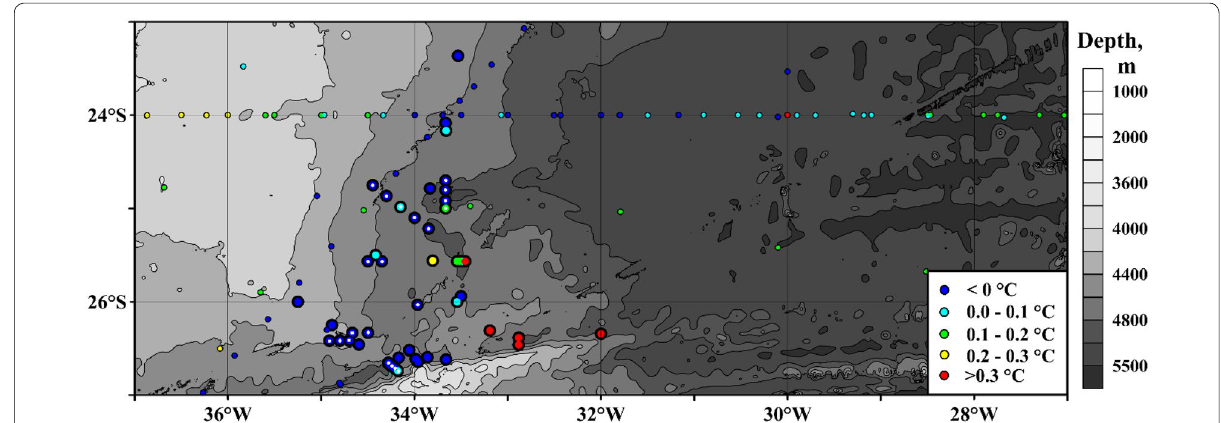
Fig. 2 Bathymetry of the study region north of the Vema Channel based on (GEBCO 2019). Locations of our CTD/LADCP casts in 2003–2020 (large circles) and historical stations (small circles) are shown. The corresponding potential temperatures at the bottom (5–20 m above the bottom) are shown in color. Stations in December 2019 and March–April 2020 are indicated with a white dot in the